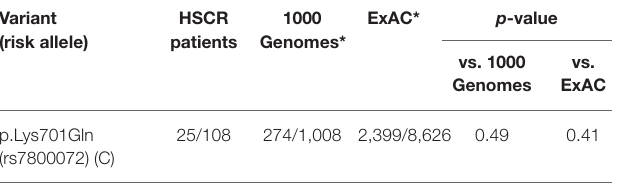
HSCR 1000 ExAC* p -value patients Genomes* vs. 1000 vs. Genomes ExAC 25/108 274/1,008 2,399/8,626 0.49 0.41